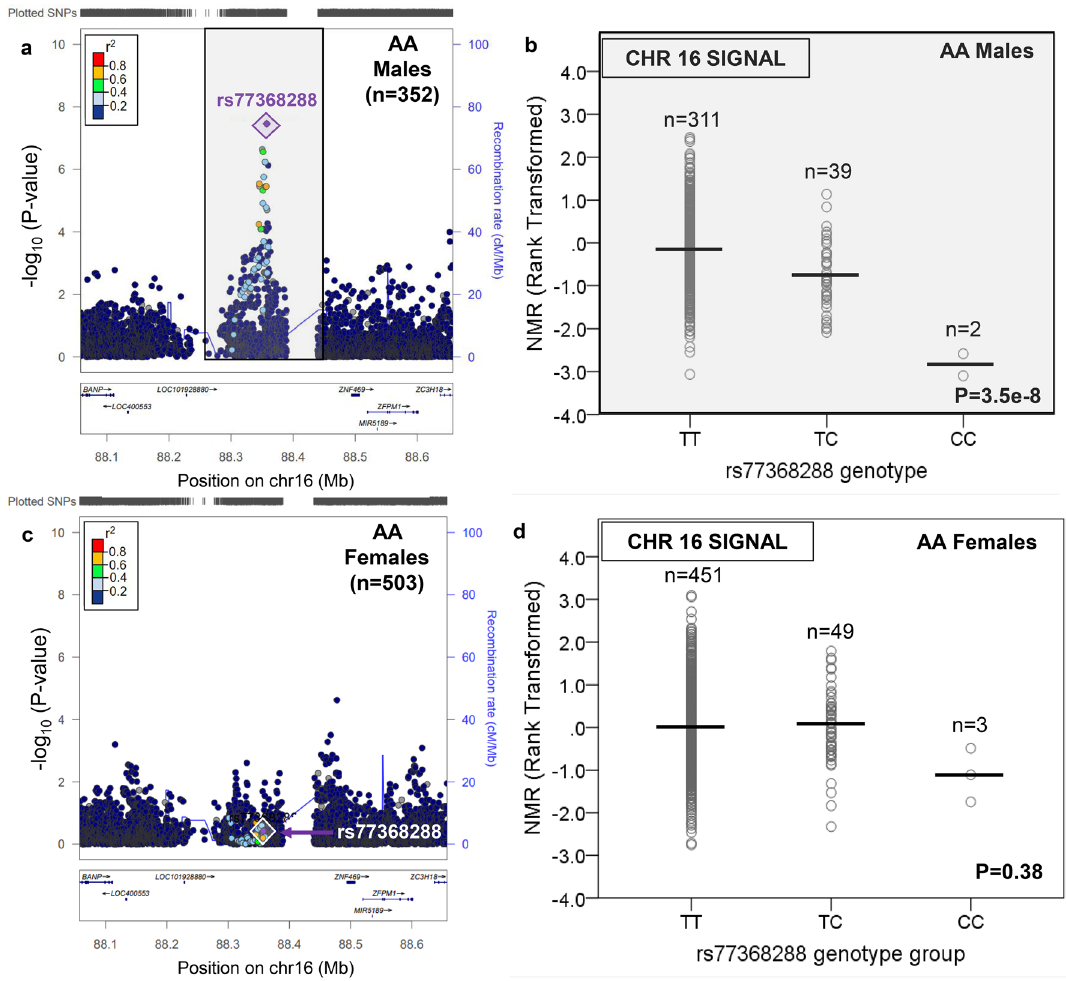
Figure 5. There was a chromosome 16 signal associated with the Nicotine Metabolite Ratio in African American males which was not significant in African American females. The nicotine metabolite ratio was rank-transformed for analysis. A regional plot, generated using LocusZoom LocusZoom 44 (freely available at locuszoom.org), shows the top overall chromosome 16 variant (rs77368288) in AA males ( a ); the influence of rs77368288 on the Nicotine Metabolite Ratio (NMR) in AA males is shown in ( b ). The chromosome 16 locus containing rs77368288 was not significant in AA females ( c ); the lack of influence of rs77368288 on the NMR in AA females is shown in ( d ). Linkage disequilibrium patterns in ( a ) and ( c ) are based upon the hg19/1000 Genomes November 2014 release African reference population. The plots in ( b ) and ( d ) were created using SPSS version 23 (can be purchased from IBM, Armonk, New York, USA). The black horizontal line represents the mean rank-transformed NMR in each group, and the P-value is from the GWAS after adjusting for population substructure and NMR